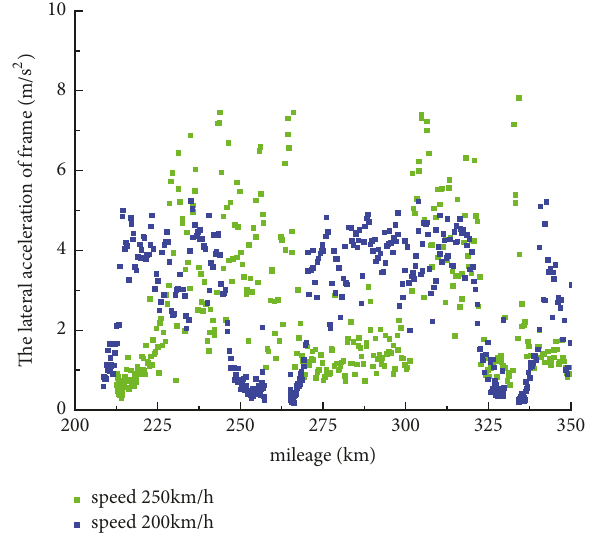
Figure 9: The lateral acceleration scattered plot of bogie frame under different speeds.